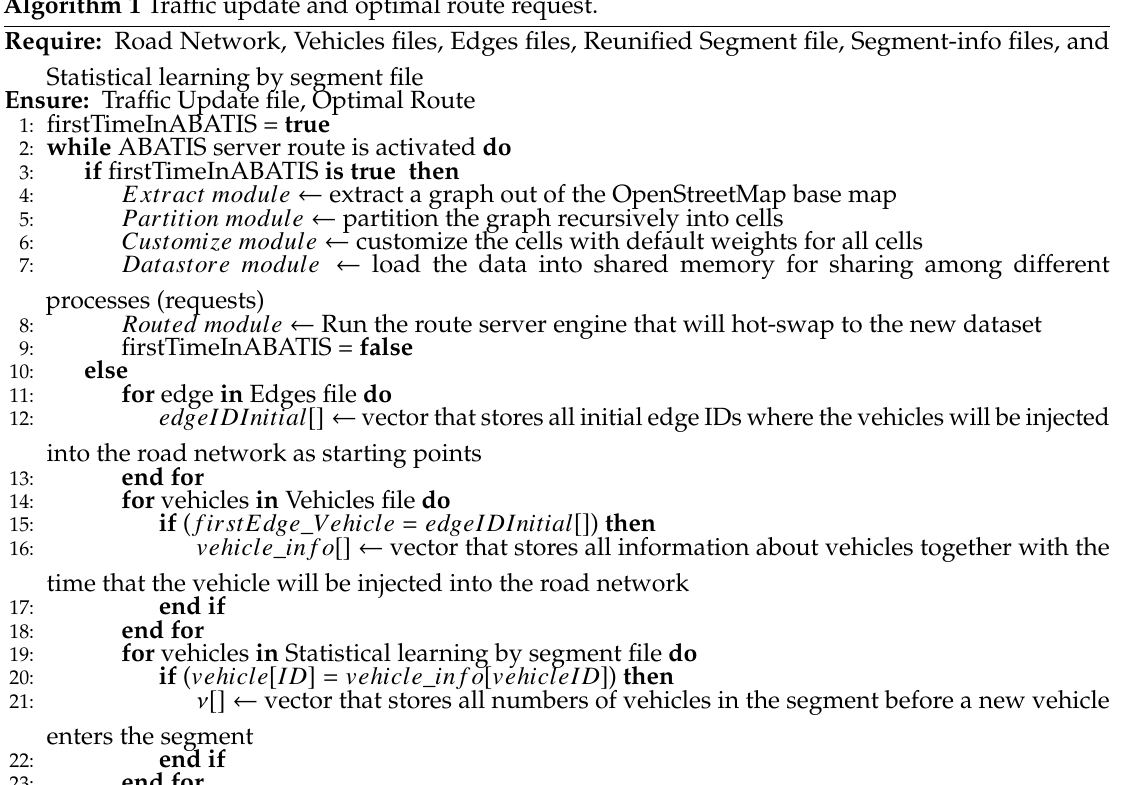
Algorithm 1 Traffic update and optimal route